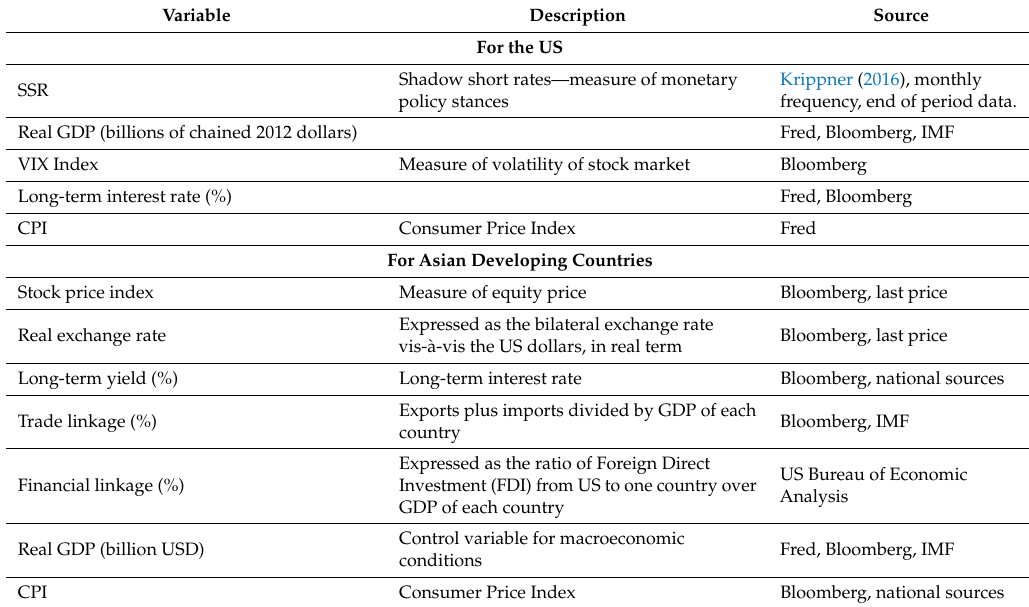
Table A1. Data description and